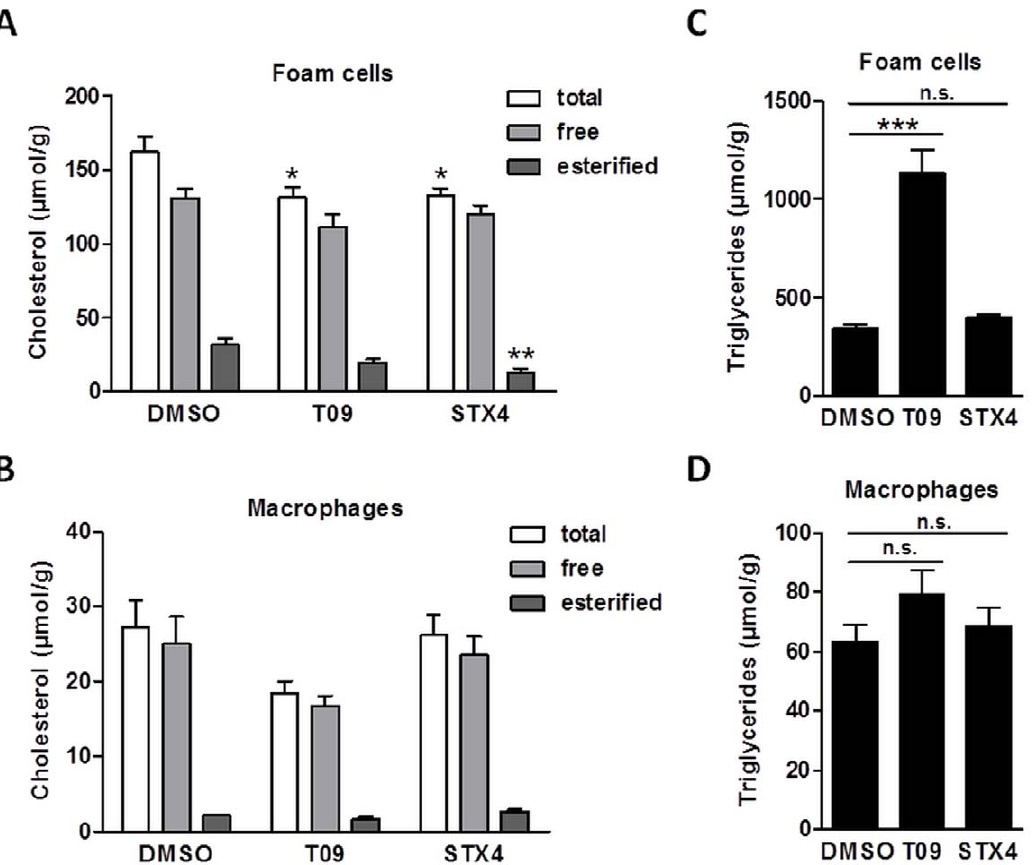
Figure 4. Physiological analyses of STX4 treatment confirm unique STX4 properties in foam cells. A , Cholesterol content in foam cells after treatment for 48 h with DMSO (0.1%), T09 (10 m M) or STX4 (10 m M). Data are expressed as mean 6 SEM (n=5–6). B , Cholesterol content in macrophages after treatment for 48 h with DMSO (0.1%), T09 (10 m M) or STX4 (10 m M). Data are expressed as mean 6 SEM (n=5–6). C , Triglyceride content in foam cells after treatment for 48 h with DMSO (0.1%), T09 (10 m M) or STX4 (10 m M). D , Triglyceride content in macrophages after treatment for 48 h with DMSO (0.1%), T09 (10 m M) or STX4 (10 m M). Data are expressed as mean 6 SEM (n=5–6). ***P , 0.001 vs. DMSO; n.s., not